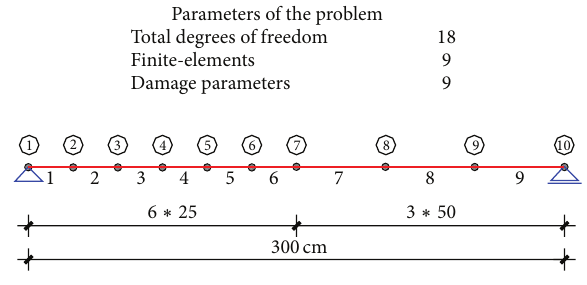
Parameters of the problem Total degrees of freedom